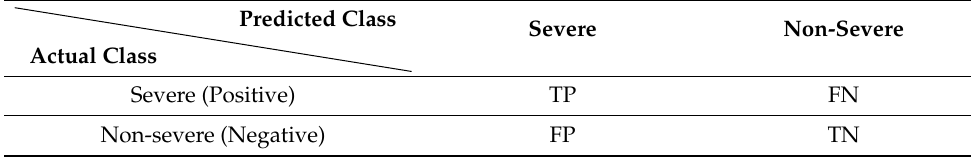
Table 5. The confusion matrix for severity prediction.